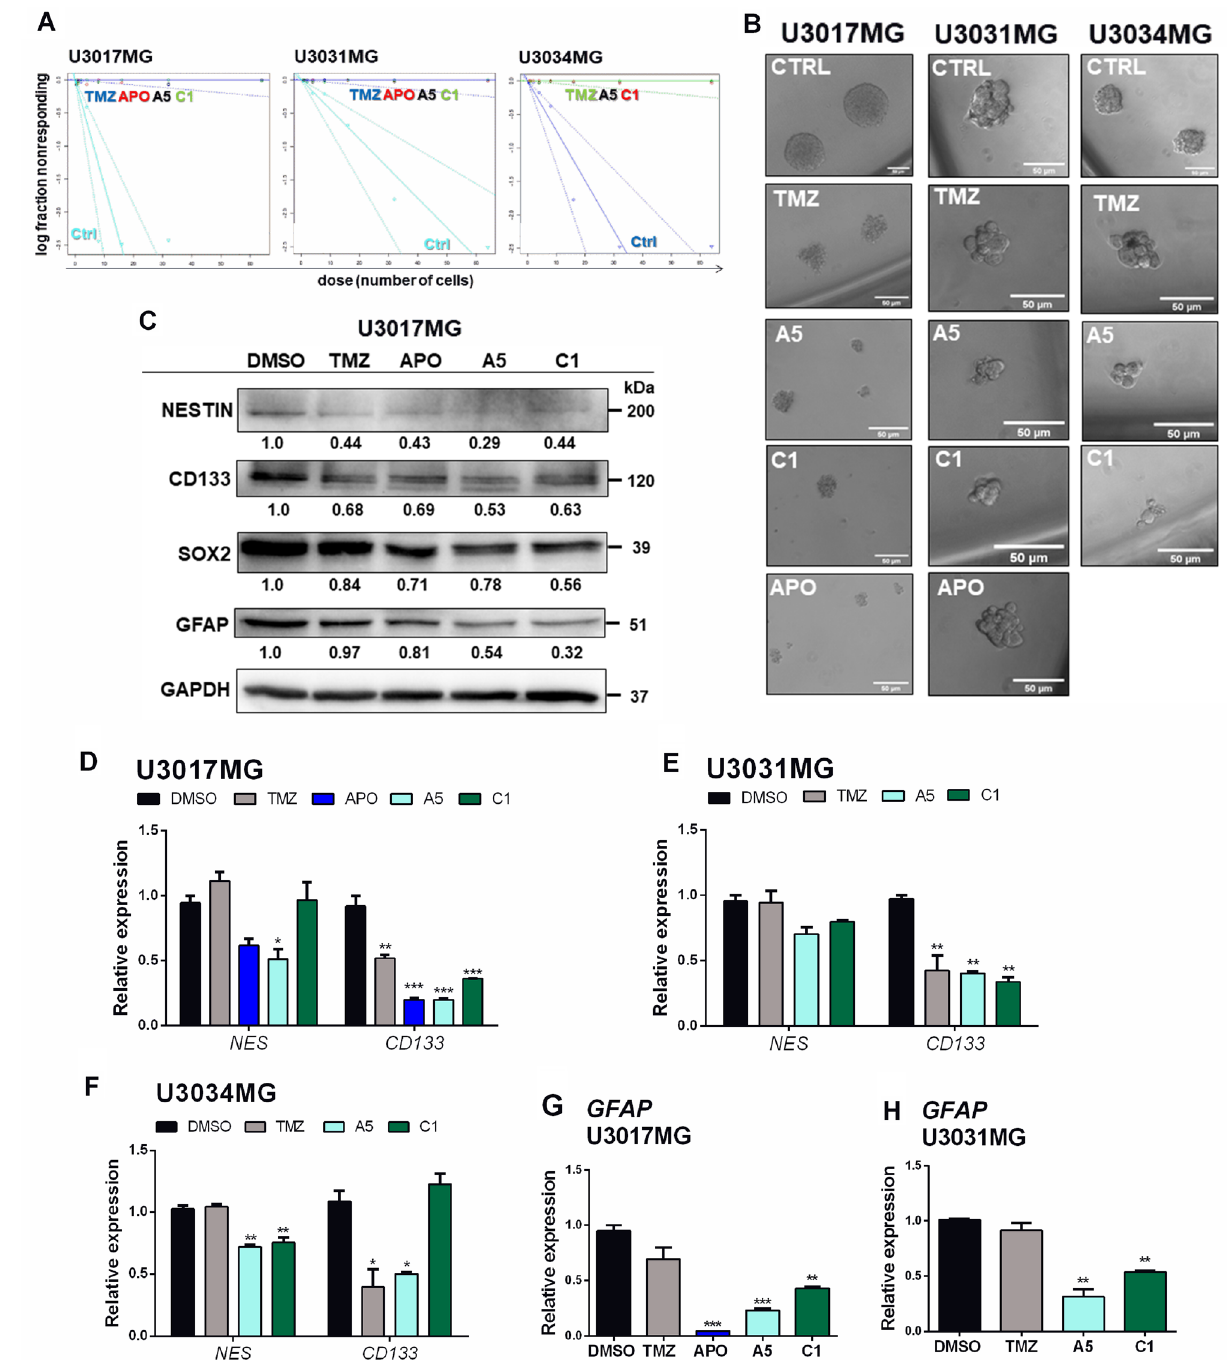
Figure 3. Aporphine and isoquinoline derivatives block gliomasphere formation. ( A ) Extreme limiting dilution assay of three patient-derived GBM cell lines (U3017MG, U3031MG and U3034MG) treated with DMSO (CTRL), TMZ (150 µM), APO (25 µM), A5 (30 µM) or C1 (30 µM) for seven days. The number of sphere ‐ containing wells (> 50 μm) per plating density was plotted. Steeper slopes indicate higher frequencies of sphere ‐ forming cells. ( B ) Representative microscopy figures of gliomaspheres formed after treatment with CTRL, TMZ, A5, C1 or APO for seven days. Magnification bars: 50 μm. ( C ) Immunoblot analysis of NESTIN (NES), CD133, SOX2, and GFAP levels in U3017MG cells; GAPDH was used as a normalization control for protein analysis, and molecular mass (kDa) markers are indicated along with densitometric values of normalized band intensity. The grouping of blots was cropped from different parts of the same gel. RT-qPCR was used for detection of stemness markers NES and CD133 in U3017MG ( D ), U3031MG ( E ) and U3034MG ( F ) treated with TMZ, APO, A5 or C1 for 48 h. RT-qPCR was used for detection of GFAP in U3017MG ( G ) and U3031MG ( H ) treated with TMZ, APO, A5 or C1 for 48 h. All the relative expression levels were normalized to GAPDH expression and calculated using the 2 −ΔΔCt method. Error bars represent SD from three biological replicates (* p < 0.05, ** p < 0.01, *** p <